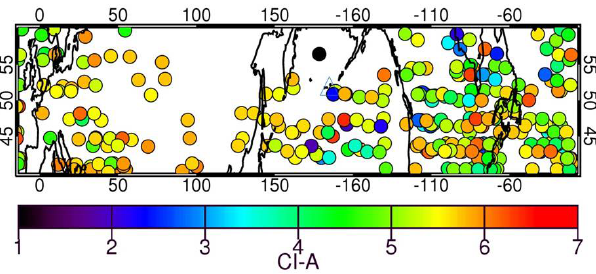
Fig. 12. Map of MIPAS CI-A corresponding to CATH in the range of 15km to 20km between 60 ◦ N and 40 ◦ N from 7 August (first Kasatochi eruption) to 31 August 2008. Location of Mount Kasatochi at 52 ◦ N, 175 ◦ W is indicated by the blue triangle.